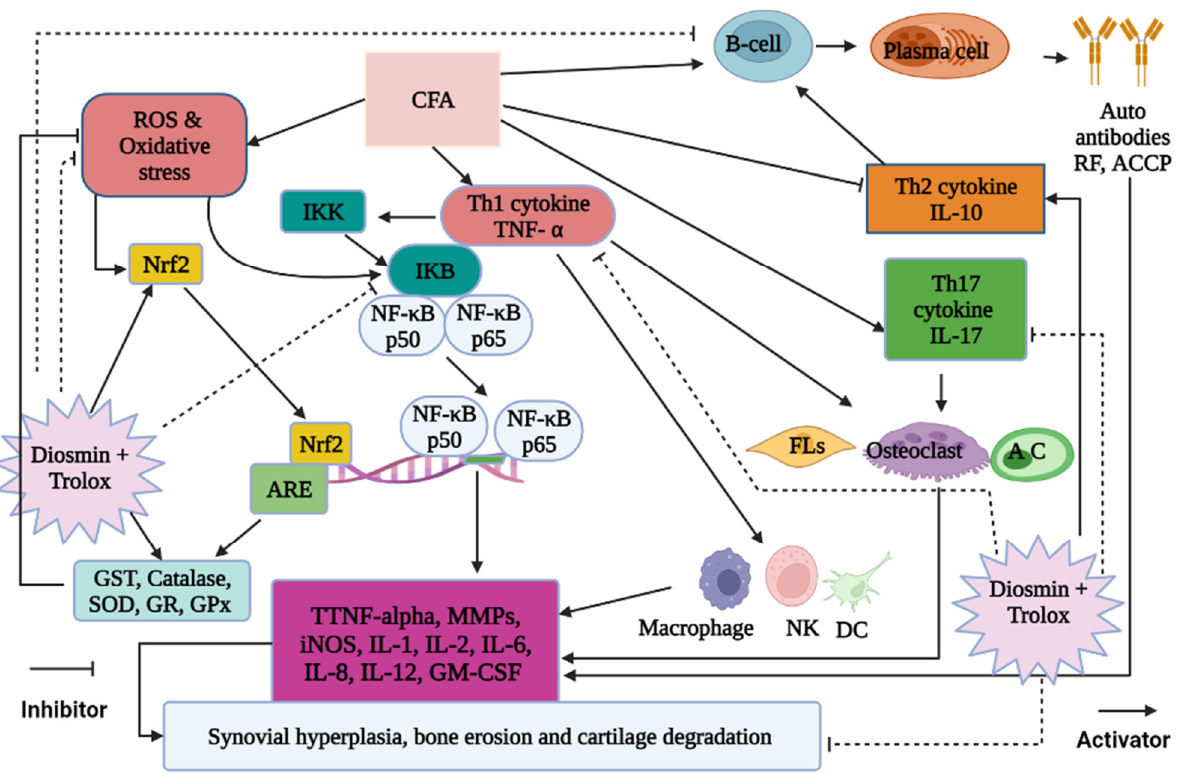
Figure 12. Schematic figure showing the mechanisms of actions of diosmin and trolox in arthritic